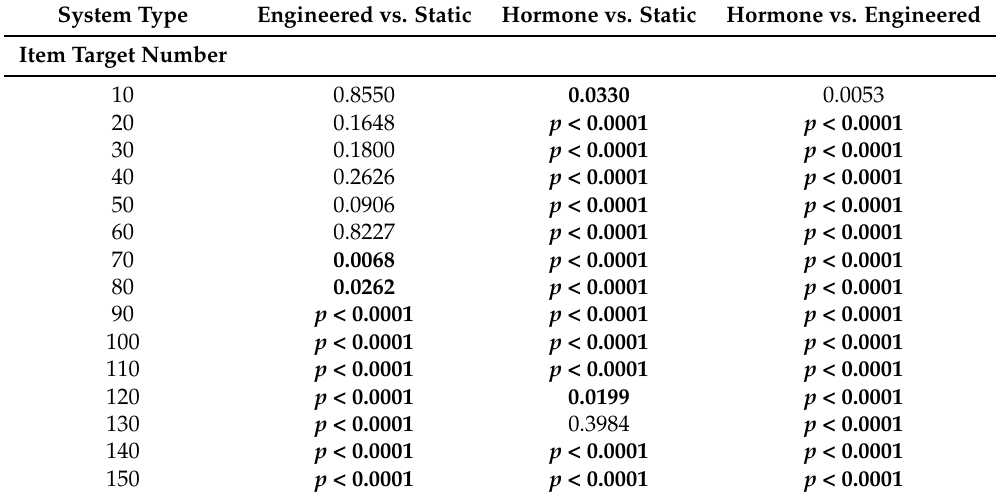
Table 2. Environment 1: Wilcoxon rank sum tests comparing the three systems for the tested item collection targets between 10–150 in terms of energy efficiency. Significant differences (indicated by a p value of <0.05) are highlighted in bold